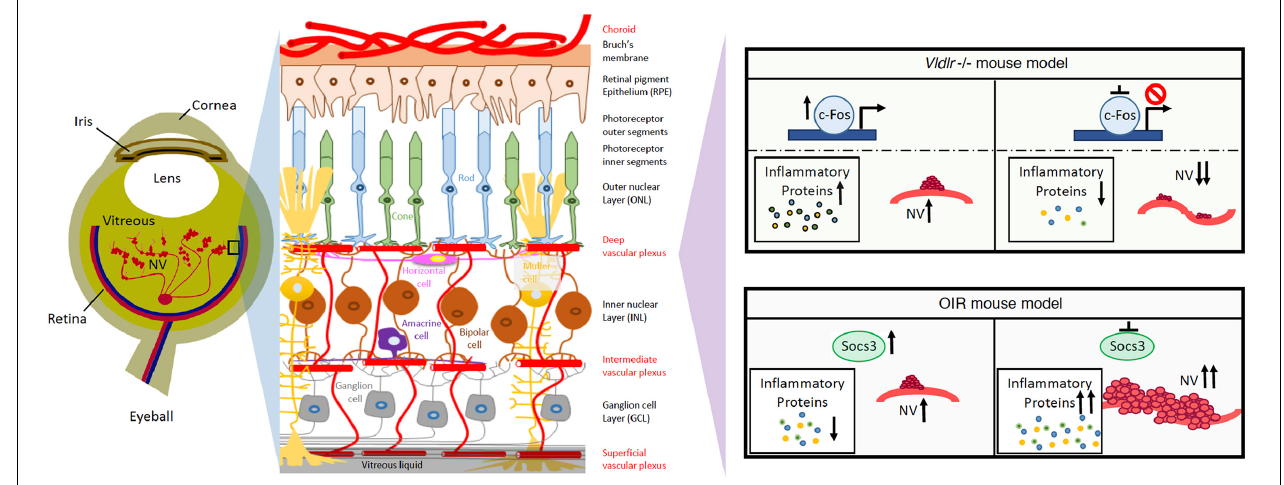
FIGURE 1 | Schematics of neuroinflammation and neovascularization in retina angiogenesis mouse models. Targeting master inflammatory regulators, Socs3 or c-Fos, may provide new ways to reduce neuroinflammation and prevent the development of NV in retinopathies.